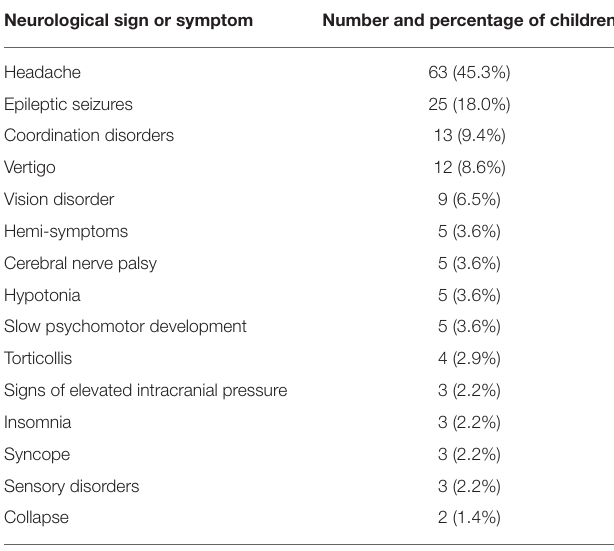
TABLE 1 | Neurological signs and symptoms, reported at the first examination by a